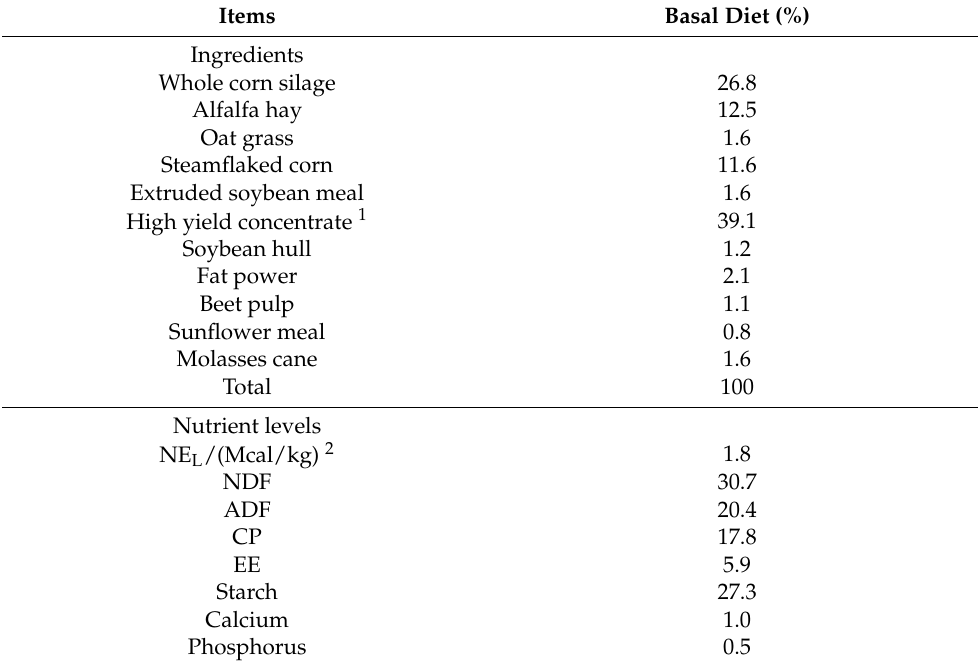
drinking water ad libitum. The experimental period lasted approximately 70 days (from 18 January to 27 March 2020), including 10 days for dietary adaptation. The trial was carried in northern China. Table 1. Composition and nutrient levels of the basal diet (DM